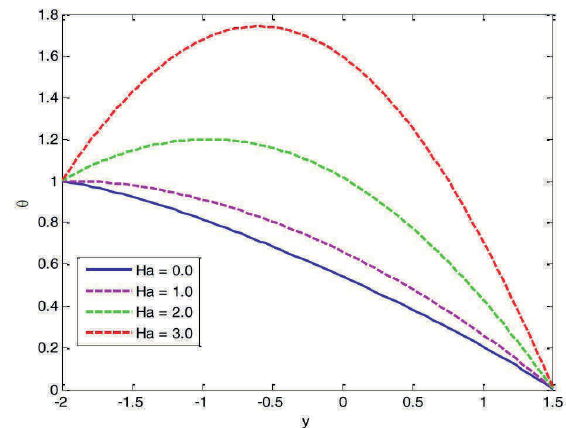
Fig. 13: Impact of Deborah number Γ on temperature.